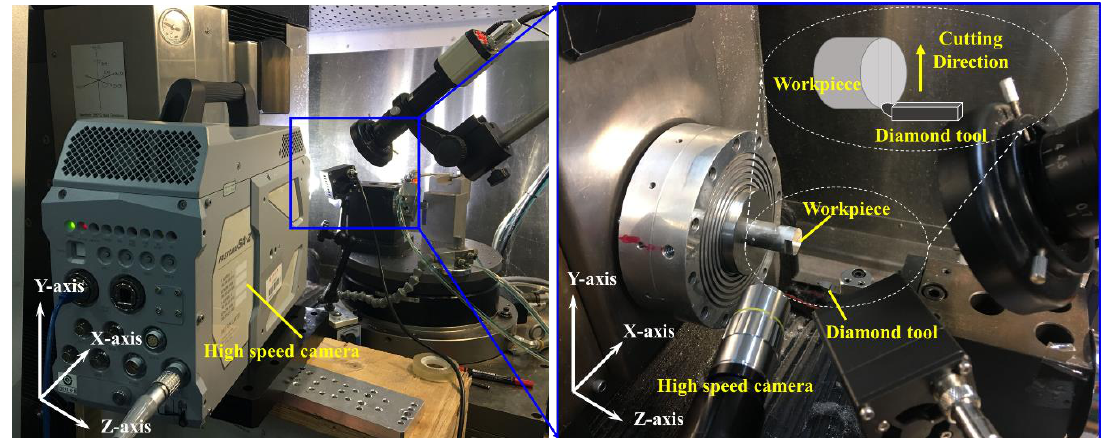
Figure 1. Observation of the diamond cutting process with a high-speed camera.